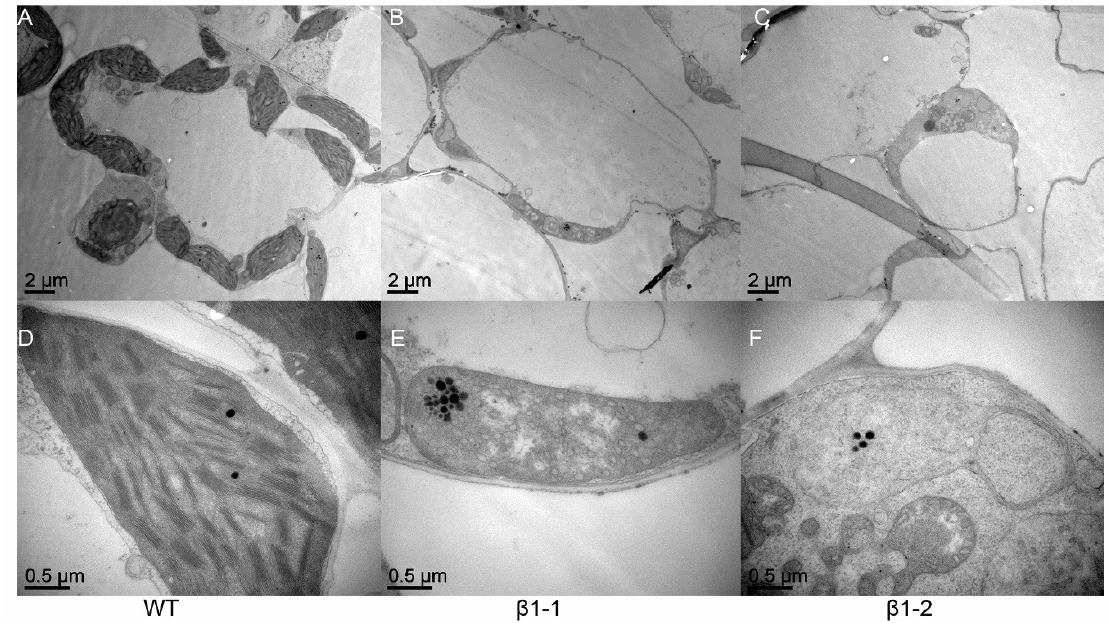
Figure 4. Transmission electron microscopic images of chloroplasts in WT and OsCpn60 β 1 mutants. ( A ) The cell of WT; ( B ) the cell of β 1-1 mutant; ( C ) the cell of β 1-2 mutant; ( D ) a normal chloroplast in WT; ( E ) an abnormal chloroplast in β 1-1 mutant; ( F ) an abnormal chloroplast in β 1-2 mutant.